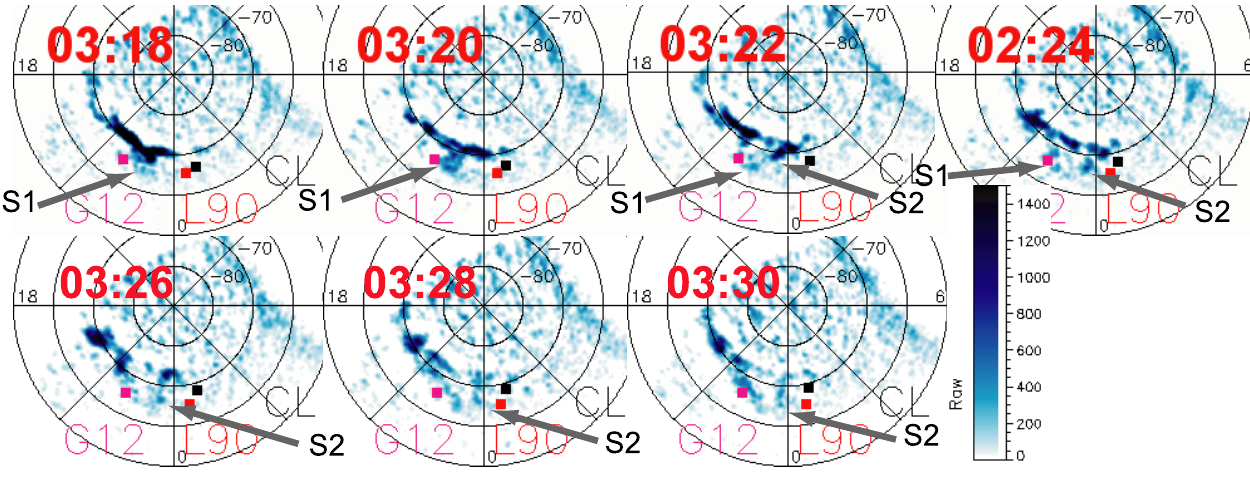
Fig. 4. IMAGE/WIC sequence for the interval 03:16–03:30 UT. Ionospheric footprints of G12, L095 and Cluster spacecraft are shown for reference by rectangles. Faint poleward boundary intensifications (probably streamers) developing equatorward are indicated by arrows “S1” and “S2”.